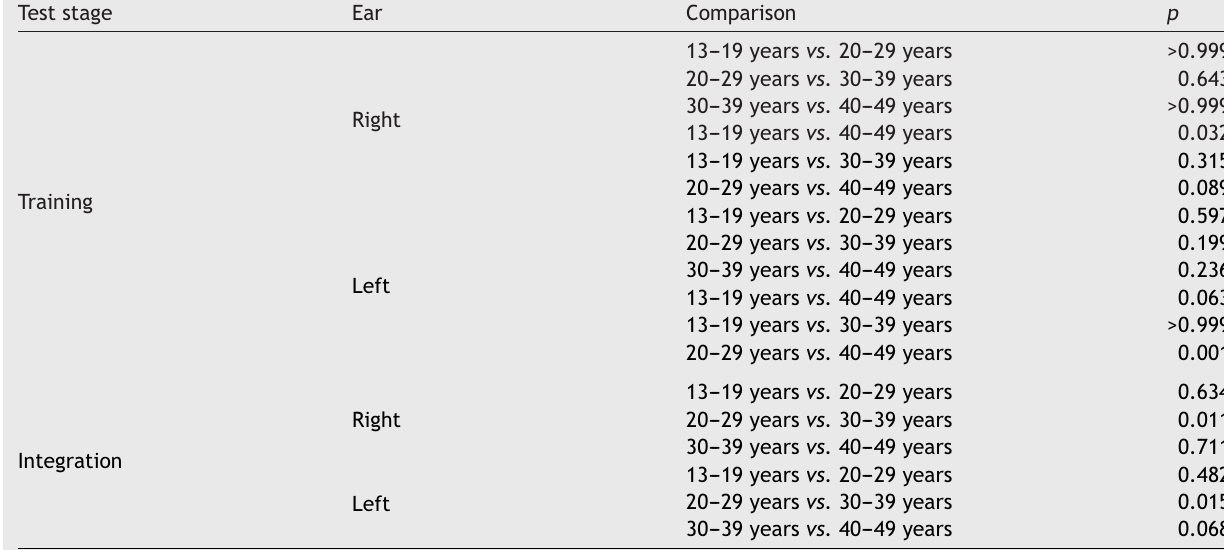
p -values obtained from multiple comparisons to locate the effect of age range in the percentage of correct answers by test stage and